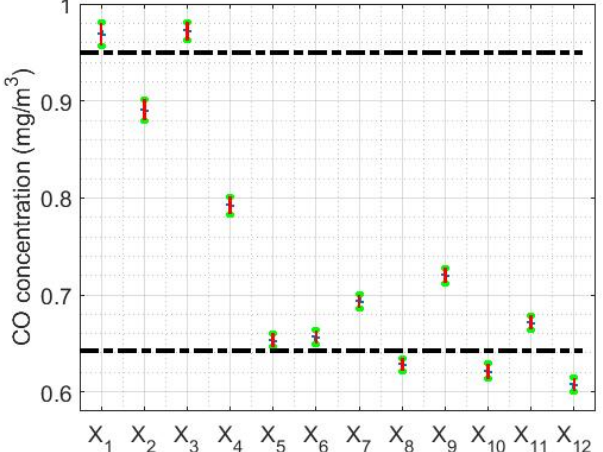
(cid:16) (cid:17) T ( 0.2 ) , s W ( 0.2 ) Figure 10. 95% confidence intervals: X 1 ( 2008 ) , X 2 ( 2009 ) , X 3 ( 2010 ) , X 4 ( 2011 ) , Figure 10. (cid:3435) (cid:1846) ( 0.2 ) ,(cid:1871) (cid:1849) ( 0.2 )(cid:3439) 95% confidence intervals: (cid:1850) (cid:2869) (2008) , (cid:1850) (cid:2870) (2009) , (cid:1850) (cid:2871) (2010) , (cid:1850) (cid:2872) (2011) , (cid:1850) (cid:2873) (2012) , (cid:1850) (cid:2874) (2013) , (cid:1850) (cid:2875) (2014) , (cid:1850) (cid:2876) (2015) , (cid:1850) (cid:2877) (2016) , (cid:1850) (cid:2869)(cid:2868) (2017) , (cid:1850) (cid:2869)(cid:2869) (2018) , and (cid:1850) (cid:2869)(cid:2870) (2019) . X 5 ( 2012 ) , X 6 ( 2013 ) , X 7 ( 2014 ) , X 8 ( 2015 ) , X 9 ( 2016 ) , X 10 ( 2017 ) , X 11 ( 2018 ) , and X 12 ( 2019 ) . Sensors 2020 , 20 , x FOR PEER REVIEW